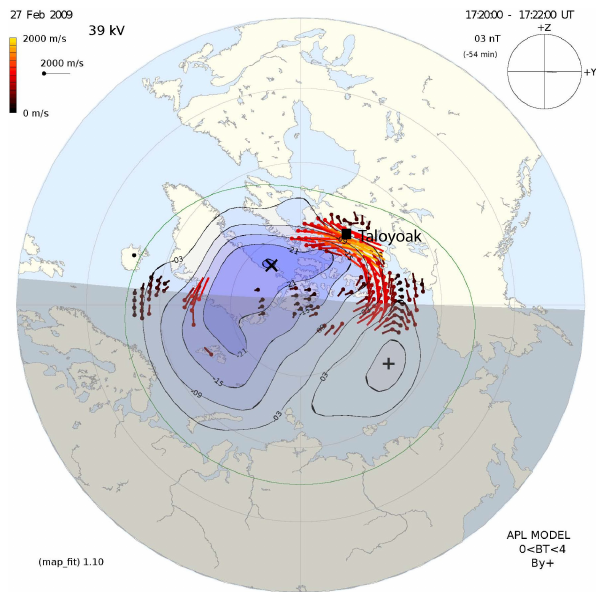
Fig. 4. SuperDARN convection map showing ionospheric flow en- Figure 4. SuperDARN convection map showing ionospheric flow enhancement in the cusp region at 730 17:20 UT. The map is in CGM coordinates with 12 MLT at the top. 731 hancement in the cusp region at 17:20UT. The map is in CGM co- 732 ordinates with 12:00MLT at the